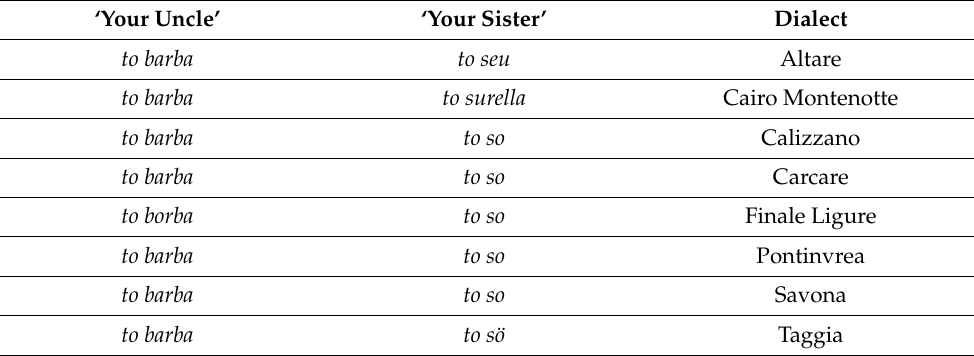
Table 12. Possessives with masculine vs. feminine kinship nouns in Ligurian dialects (Source: ASIt). ‘Your Uncle’ ‘Your Sister’ Dialect to barba to seu Altare to surella Cairo